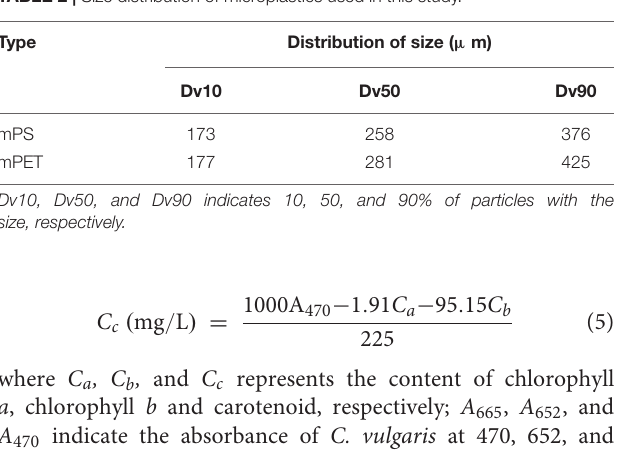
TABLE 2 | Size distribution of microplastics used in this study.